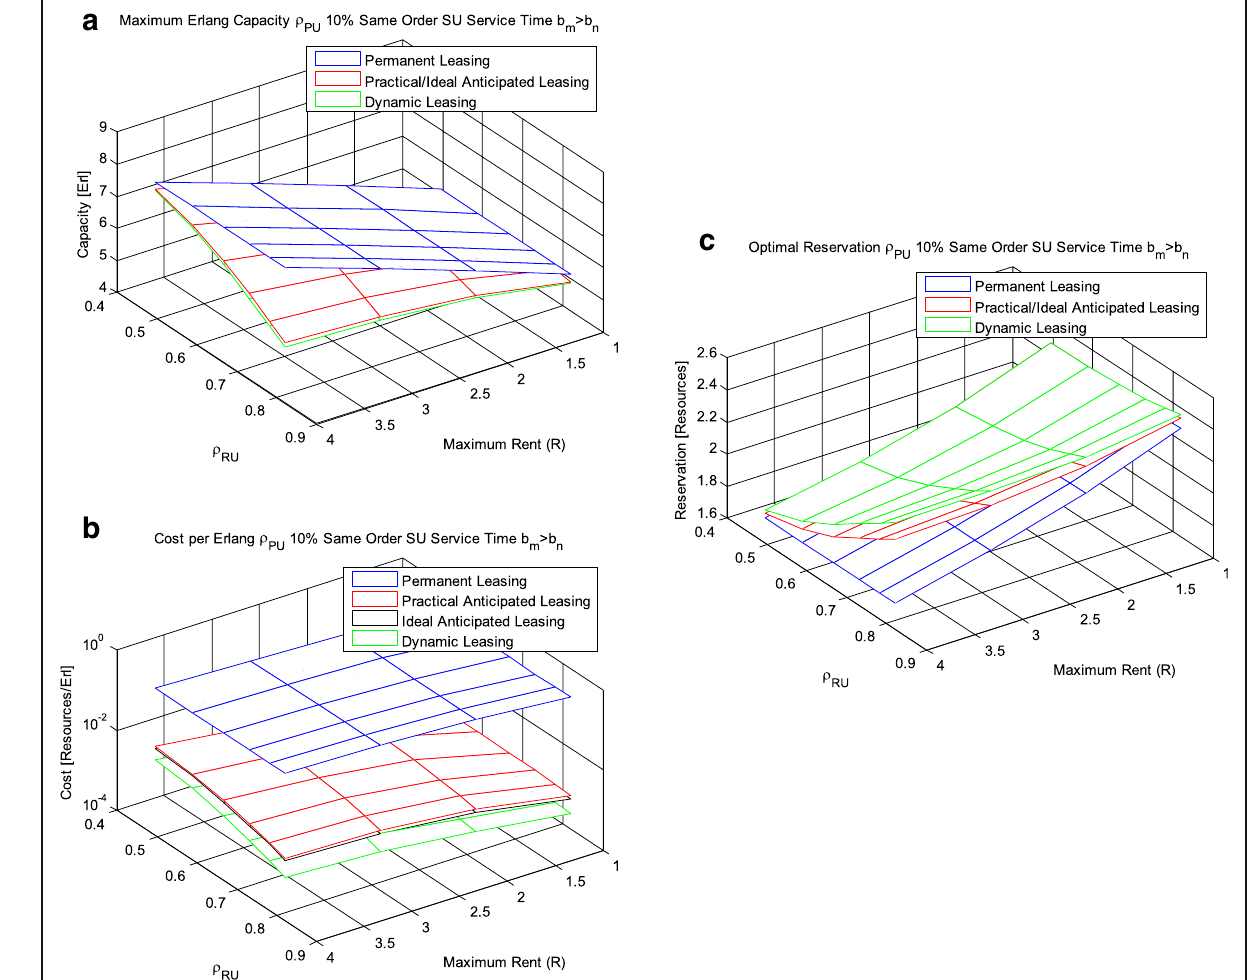
Fig. 7 Performance of spectrum leasing strategies under the system scenario in which ρ PU = 0.1, μ m / μ n = 1, and b m = 3 b n . a Maximum Erlang capacity, b cost per rented resource per achieved Erlang capacity, and c optimal number of reserved channels as function of R and ρ